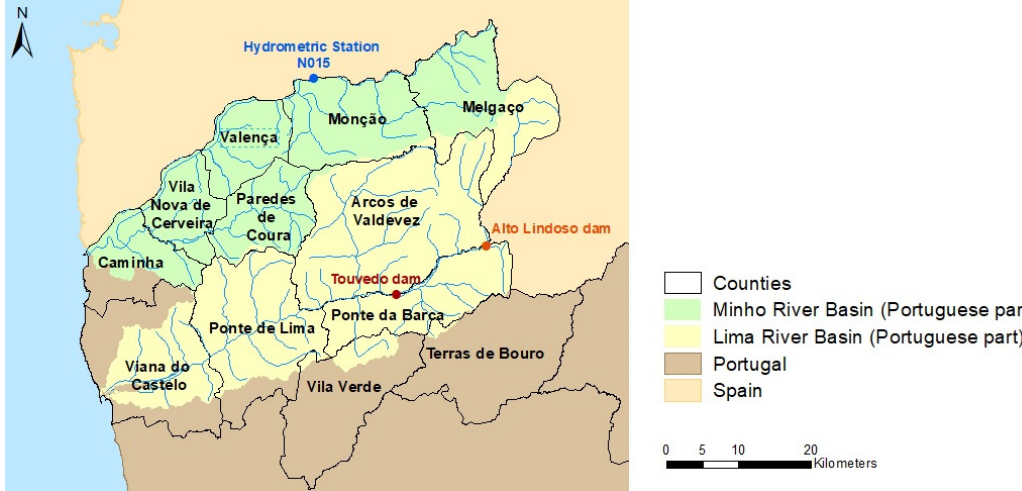
Figure 5. Counties of the Minho and Lima river basins and locations of the Touvedo dam (Lima) and hydrometric station N015 — Rio Miño en Salvaterra do Miño (Minho).